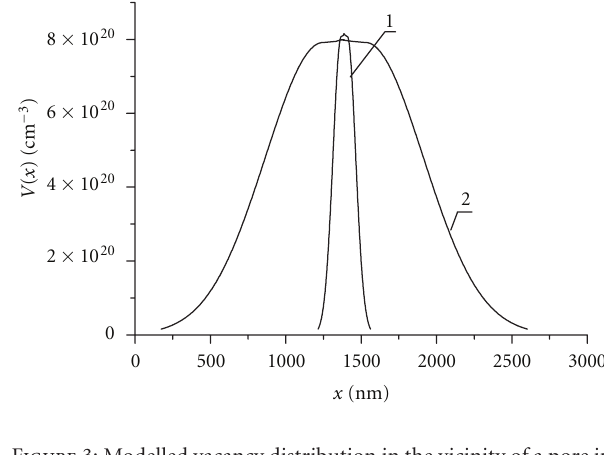
Figure 3: Modelled vacancy distribution in the vicinity of a pore in porous SiC before (curve 1) and after (curve 2) anneal at 1700 ◦ C for 120